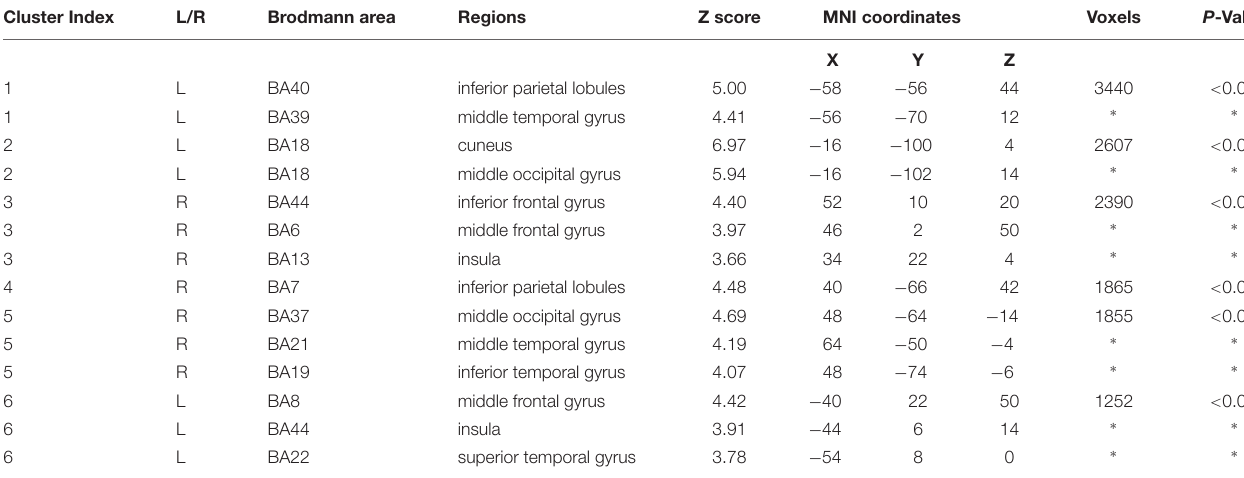
L: Left; R: Right; MNI: Montreal Neurological Institute; ∗ the peak is in the same cluster as the other peaks. All clusters survived a threshold of P < 0.05, corrected for multiple comparisons at the cluster level for the whole